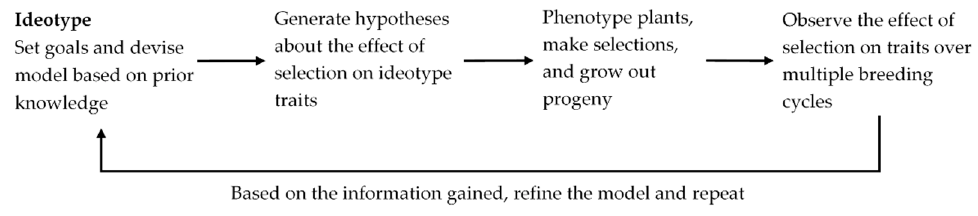
Figure 1. The reiterative ideotype approach of designing and adjusting a crop ideotype model.